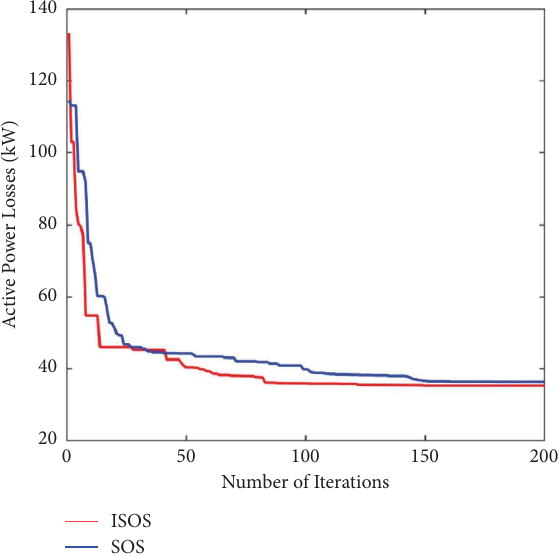
Figure 7: ISOS convergence characteristics for 69-node